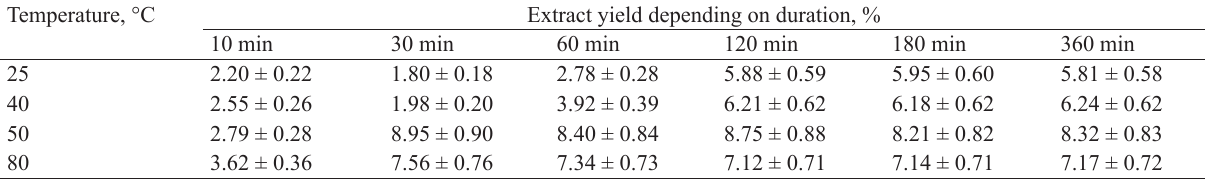
Table 4 Temperature selection for extracting biologically active substances from ginseng suspension cultures Temperature, °С Extract yield depending on duration, %